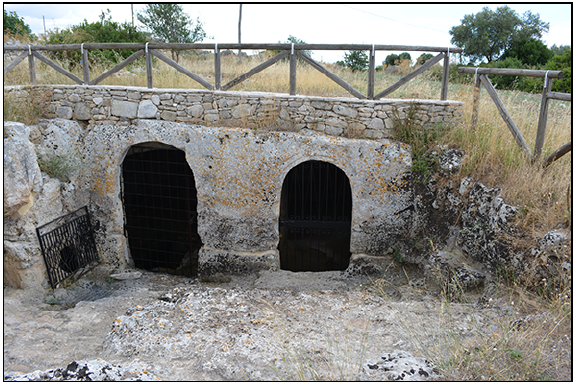
Figure 1. Entrance to the cave church Sant’Angelo